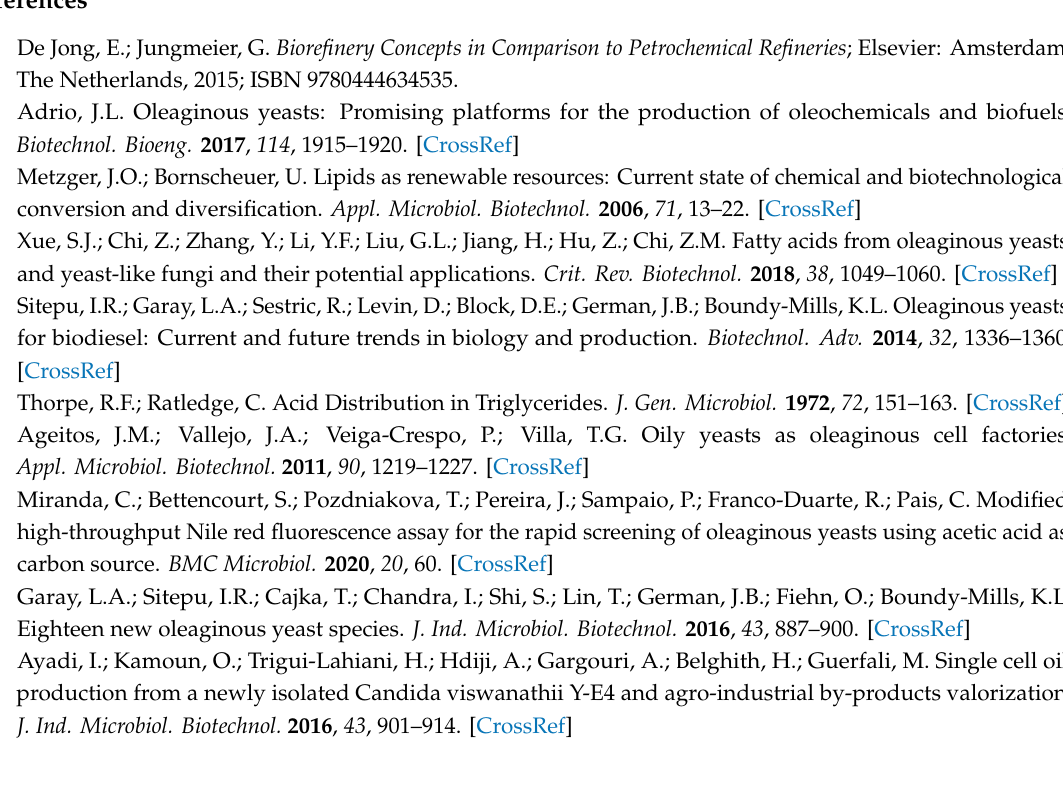
Figure S1: Time-course growth in YP:HAc (15g L − 1 ) medium, during 120 h, at pH 5.5, Figure S2: Lipid production (relative fluorescent units, RFUs) and growth (OD 640 ) normalized per gram of carbon initially added in each medium, after 120 h of growth, Table S1: Biomass, lipid production and carbon source utilization in medium containing acetic acid (15 g L − 1 ) as carbon source, at pH 5.5, Table S2: Long chain fatty acids profiles (%) obtained after 120 h of growth in medium containing acetic acid (15 g L − 1 ), at pH